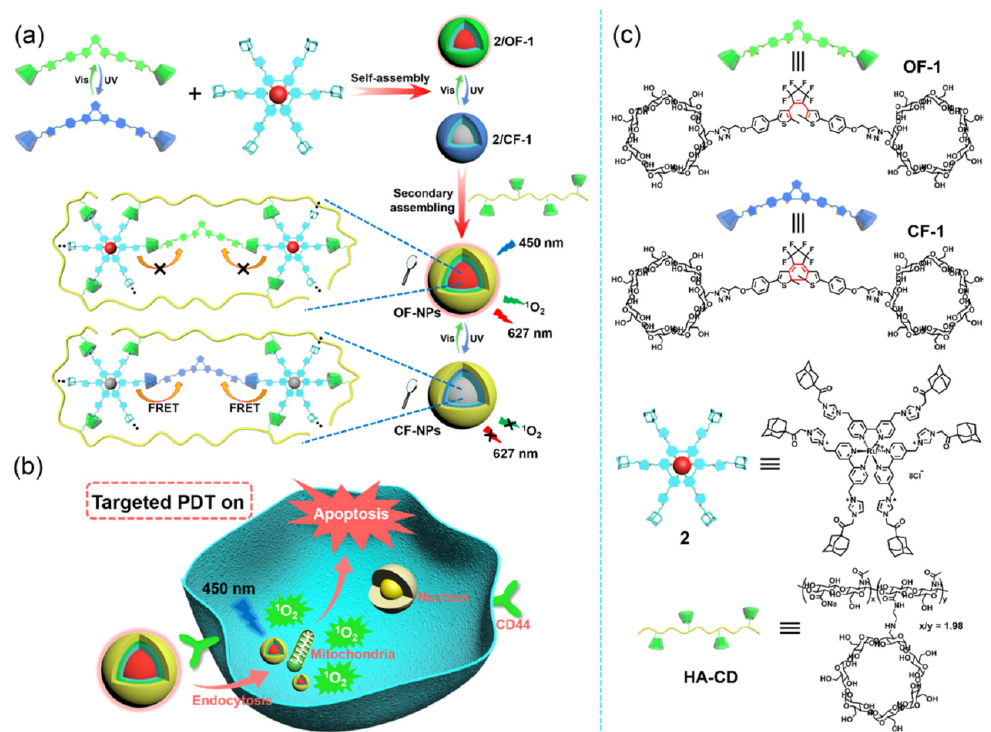
Figure 6. ( a ) Schematic diagram of the formation of CD secondary assemblies with the controllable 1 O 2 generation ability and ( b ) their application for targeted PDT; ( c ) the chemical structures of dia ‐ rylethene ‐ bridged CD in its ring ‐ opened form OF ‐ 1 and ring ‐ closed form CF ‐ 1; AD polypyridyl ru ‐ thenium photosensitizer (2) and β‐ CD ‐ grafted hyaluronic acid. (Adapted with permission from Ref. diarylethene-bridged CD in its ring-opened form OF-1 and ring-closed form CF-1; AD polypyridyl ruthenium photosensitizer (2) and β -CD-grafted hyaluronic acid. (Adapted with permission